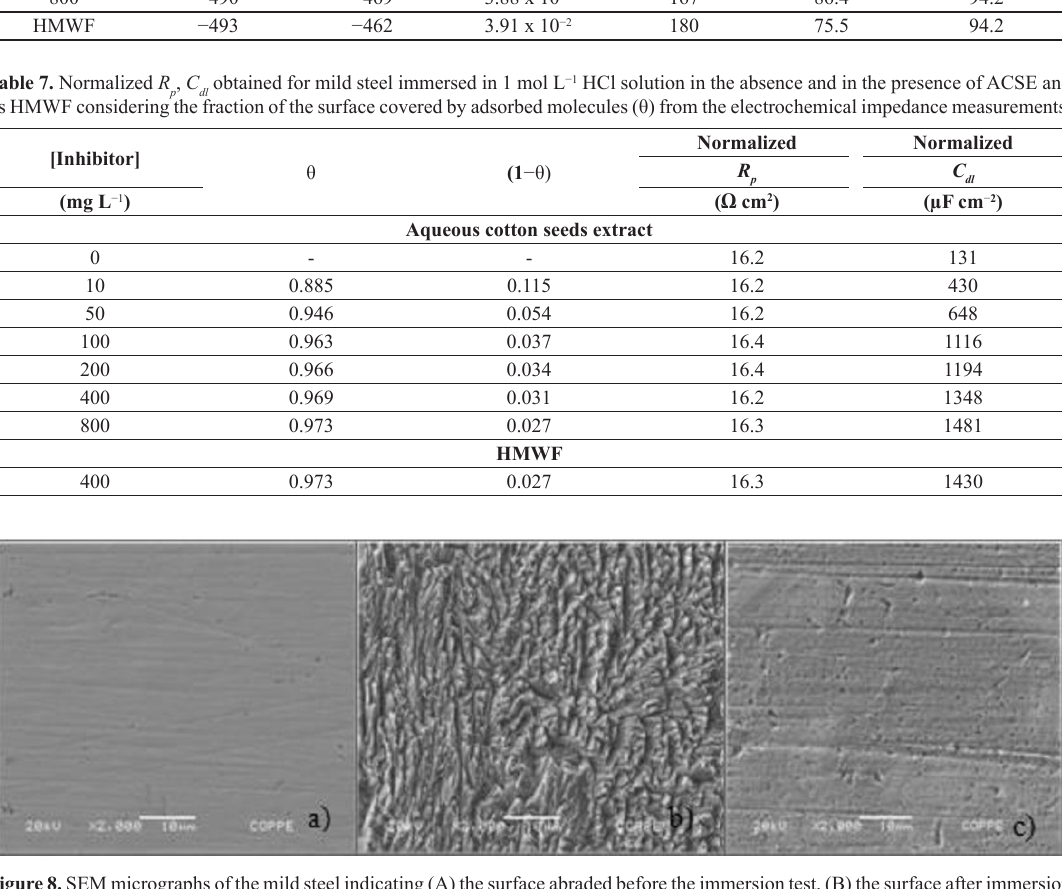
Figure 8. SEM micrographs of the mild steel indicating (A) the surface abraded before the immersion test, (B) the surface after immersion in 1 mol L −1 HCl, (C) the surface after immersion in 1 mol L −1 HCl containing ACSE.